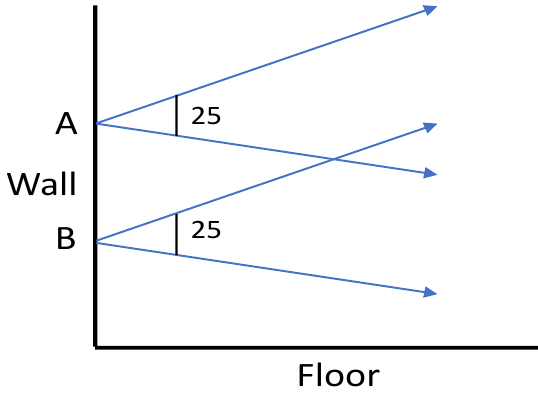
Figure 2. Thermal sensor placement for static and dynamic activity detection. Two sensors are placed on the vertical wall to increase vertical field of view